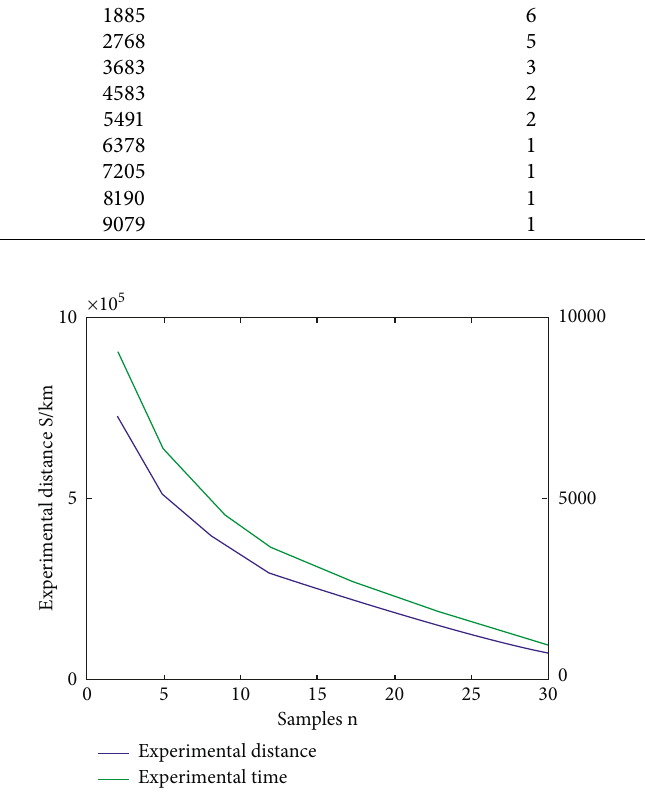
Figure 5: Relationship between sample number, test distance, and test